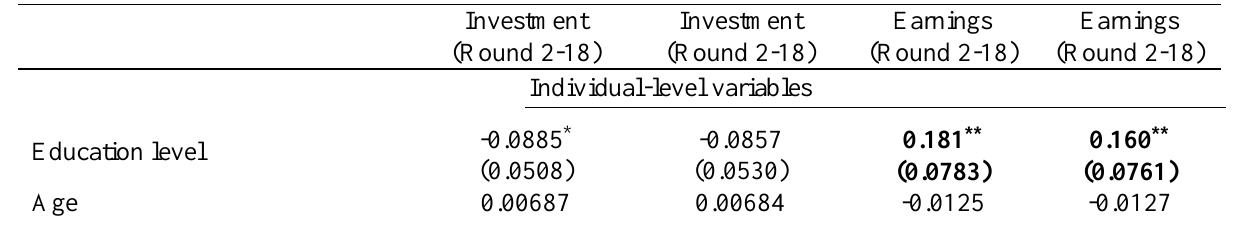
Table A4.1. Mixed-effects regression results of individual amounts invested and